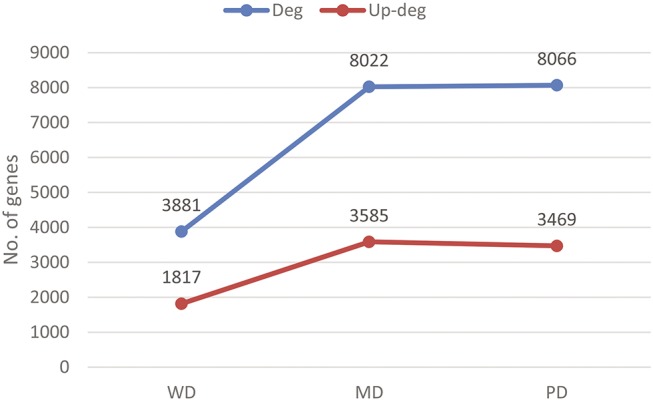
Cancer grades versus the number of differentially expressed genes.The blue and red lines are for the numbers of differentially expressed and up-regulated genes, respectively, across the three grades considered.